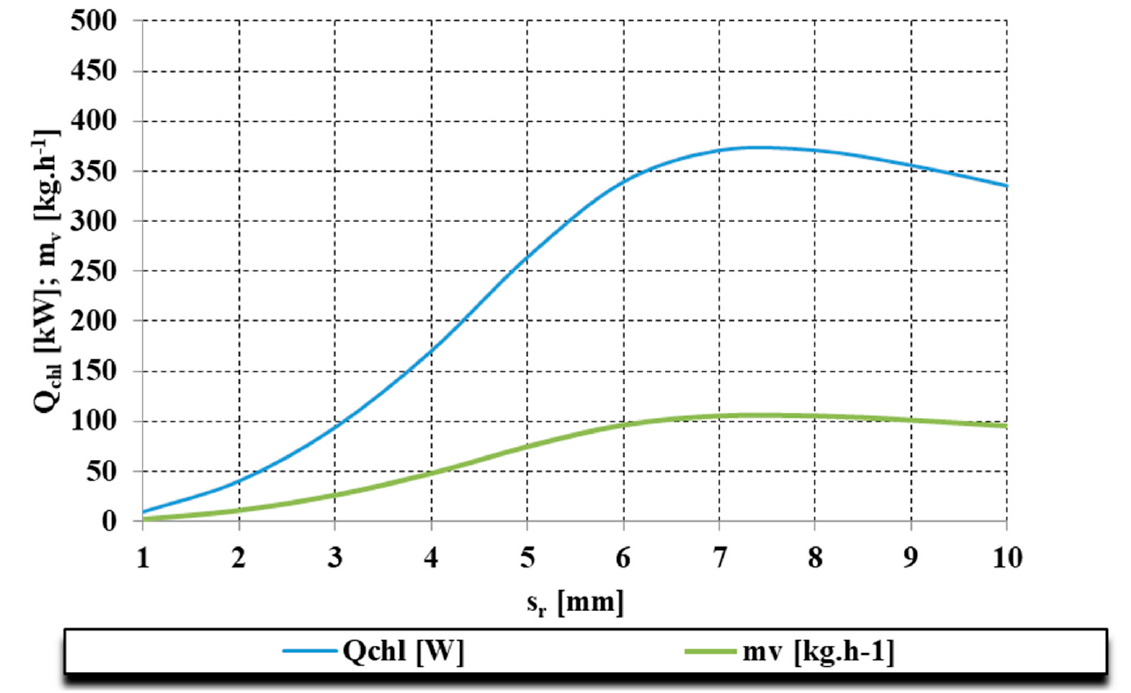
Figure 2. The results of simulations when changing the spacing of the ribs, sr.